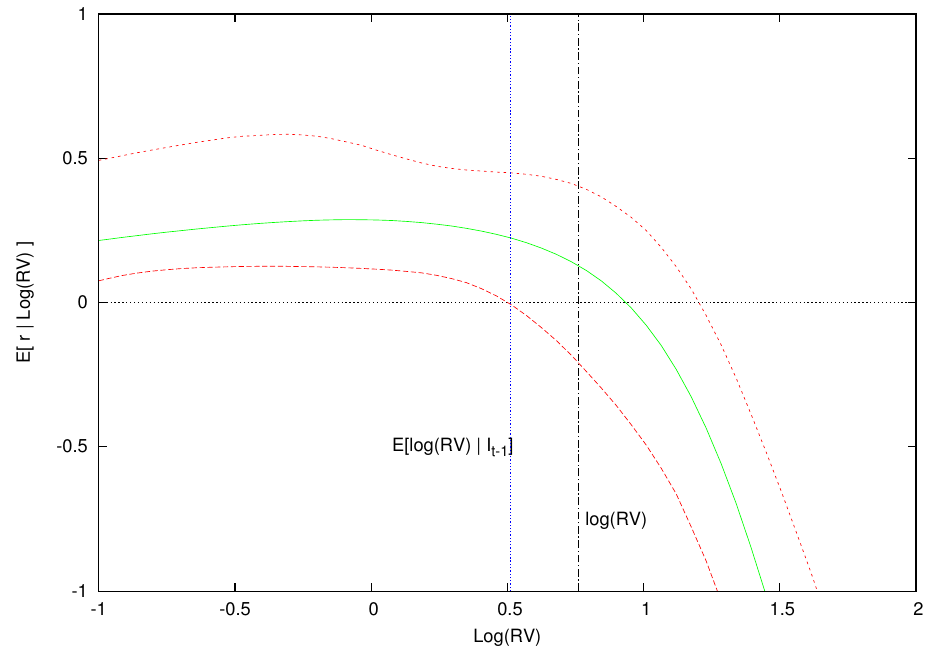
Figure 6. Expected excess return given log realized variance for the information set I t − 1 where volatility is high. This figure displays the expected excess return and 0.90 density intervals as a function of log ( RV ) conditional on regressors in the information set from I t − 1 , t = 2008 : 12, which is a high volatility period. The expected log-realized volatility based on the model is blue while the actual log-realized volatility for t = 2008 : 12 is the black vertical